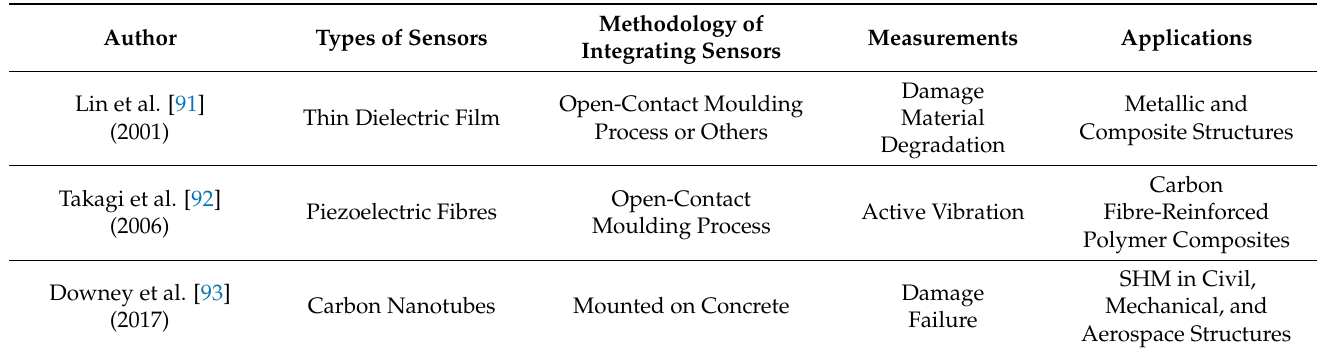
Table 6. Overview of applications and methodology of integrating other piezoelectric sensors into composite structural components.